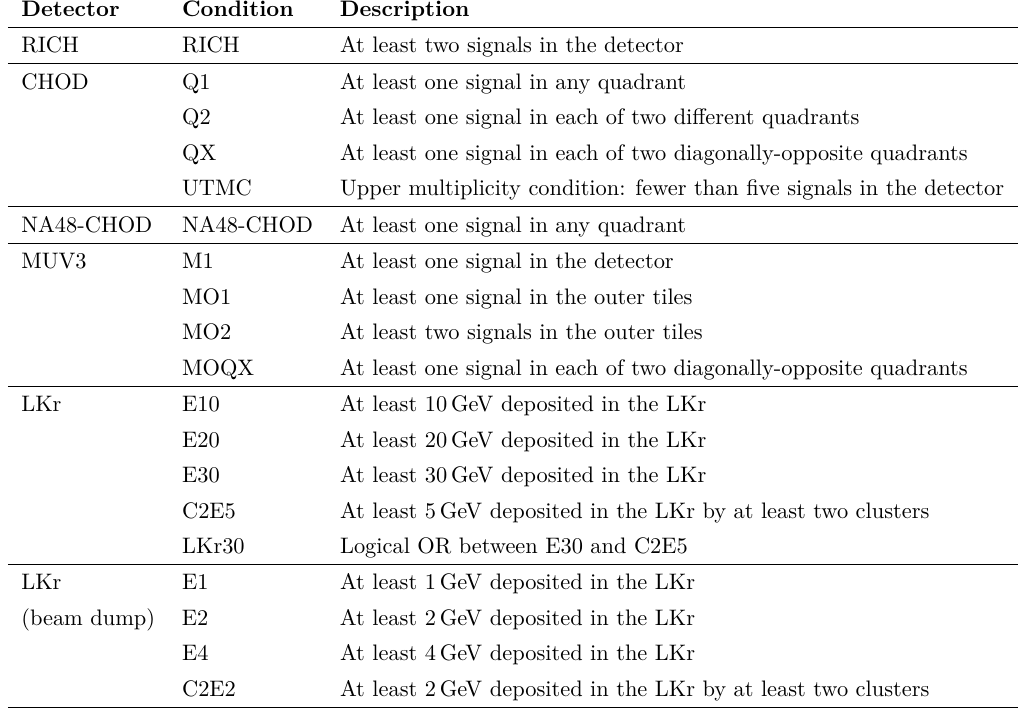
Table 1. List of L0 trigger conditions. The LKr conditions differ between K + and beam-dump